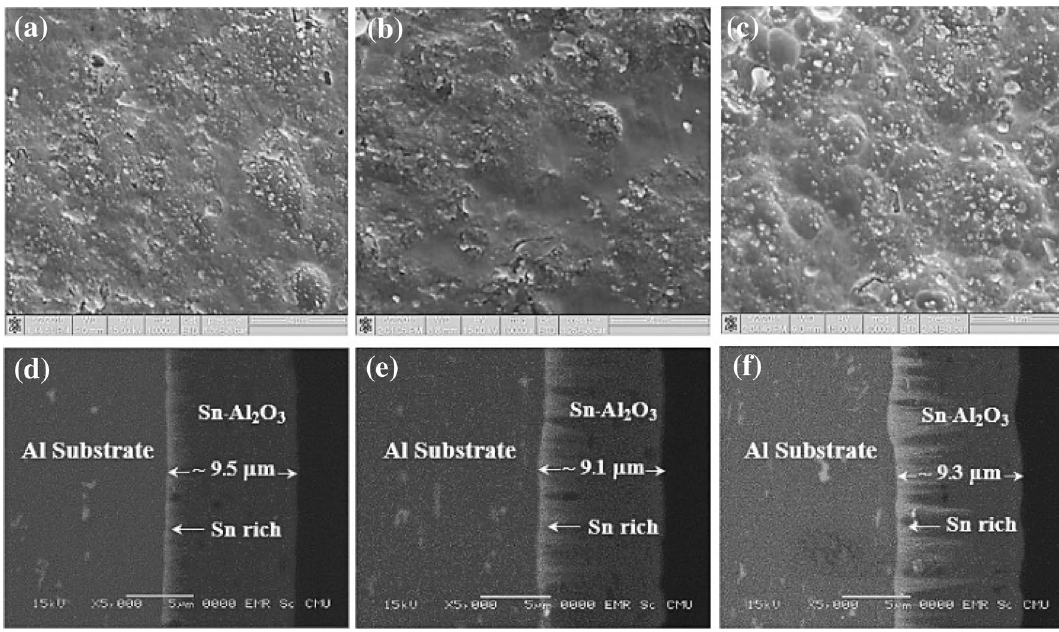
Fig. 2 LV-SEM images of ( a – c ) surface and ( d – f ) sectional image of Sn–Al